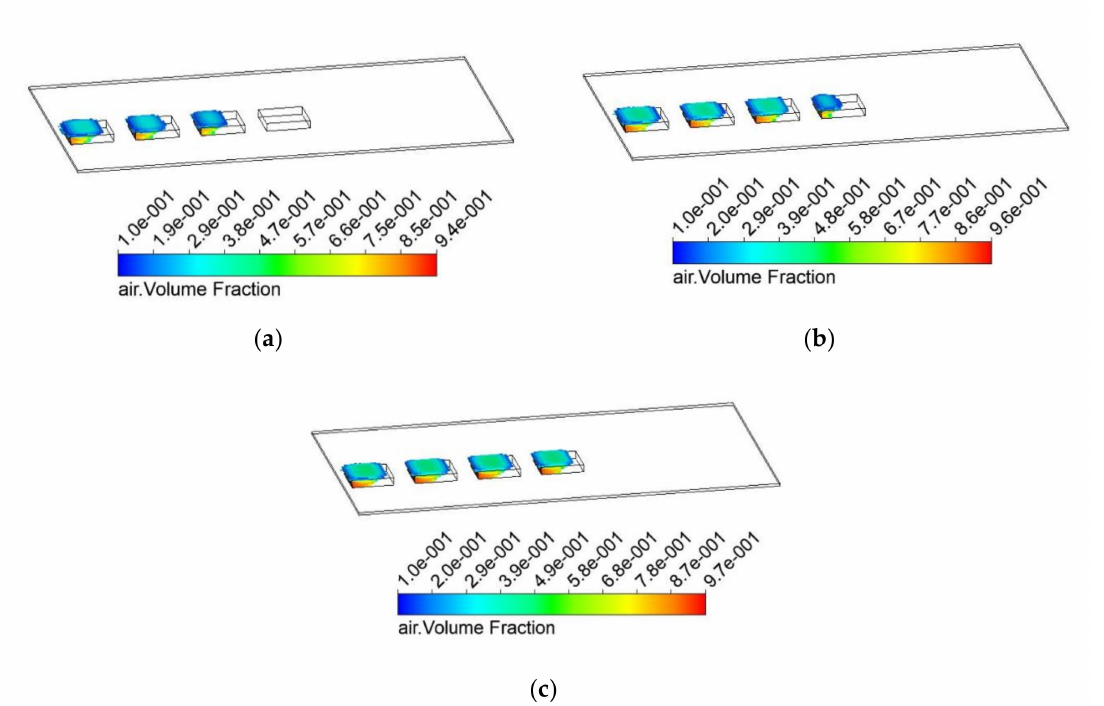
Figure 23. The air volume fraction is generated by a partial texturing configuration with dimples side 50 µ m and gap 3 µ m, sliding velocity 10 m / s. Set A of the cavitation coe ffi cients. Only the portions of the mesh where the volume fraction of air is greater than 10% are highlighted. ( a ) Saturation pressure